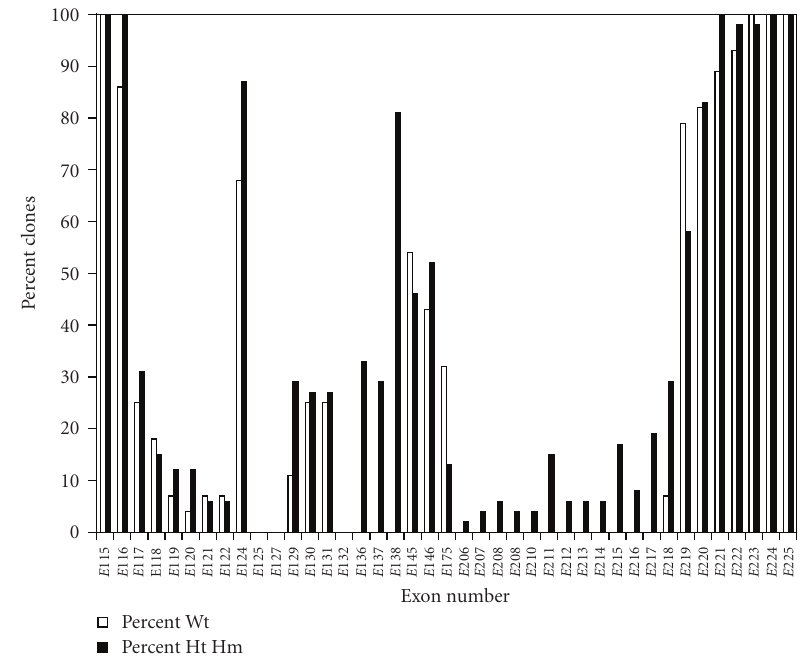
Figure 4: Exon inclusion in clones from rat left ventricle of wild type and mutant rats. The percent of clones that contain the exons shown is plotted versus exon position. Only exons 115, 224, and 225 were found in all wild type and mutant clones (heterozygote [Ht] and homozygote [Hm]). Data was pooled from four di ff erent ages